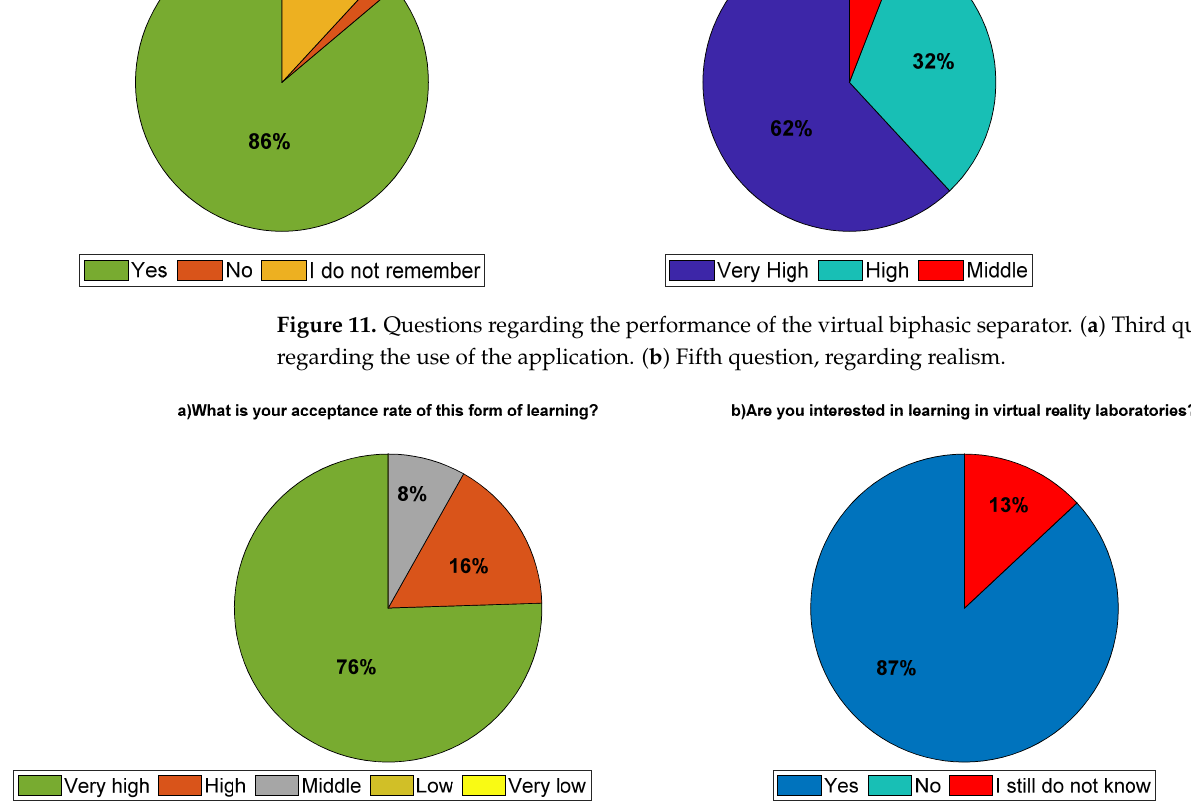
Figure 11. Questions regarding the performance of the virtual biphasic separator. ( a ) Third question, regarding the use of the application. ( b ) Fifth question, regarding realism.